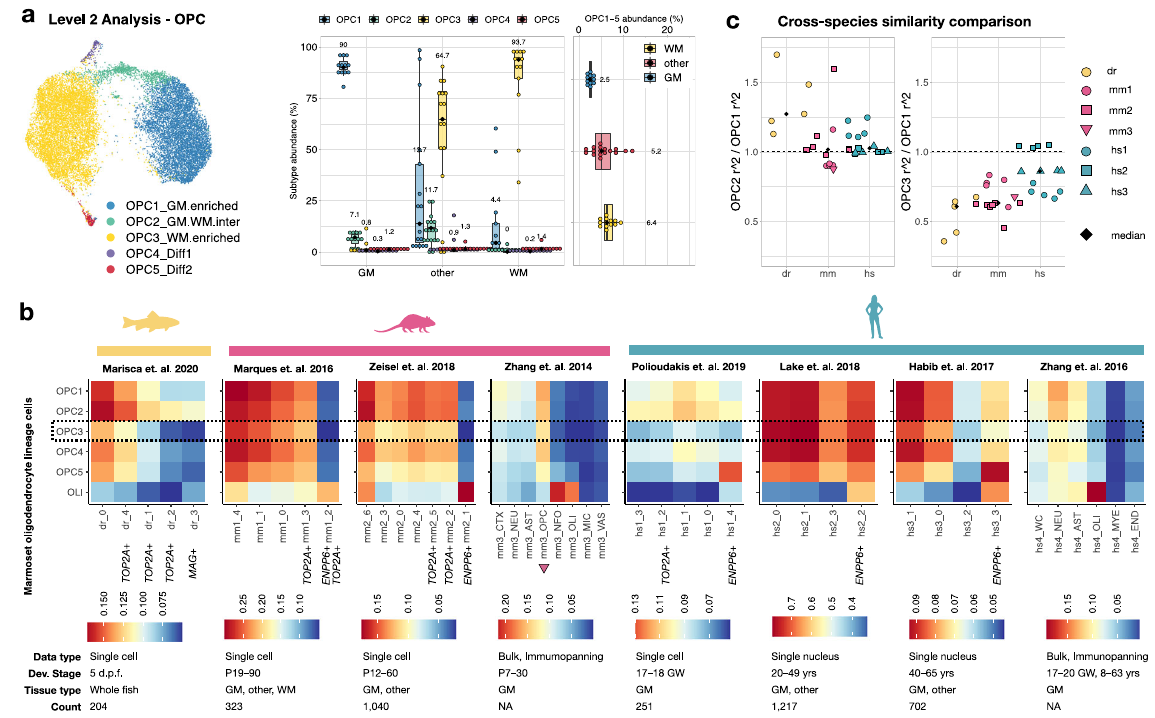
Fig. 4 | Marmoset WM-OPC form a transcriptionally disparate population that diverges from previously reported OPC in other species. a Left, UMAP plot of OPCcoloredbyLevel2subclustering.Right,relativeabundanceofOPCsubclusters in coarse tissue category; n =42 independent samples; the median is annotated (black diamond shape) and listed. The lower and upper hinges of the box plot correspond to the 25 th and 75 th percentiles, whiskers extend from the hinges to maxima or minima at most 1.5 times inter-quartile range. b Heatmap showing the Pearson ’ scorrelationcoef fi cient r )between6oligodendrocyte-lineagecellclusters